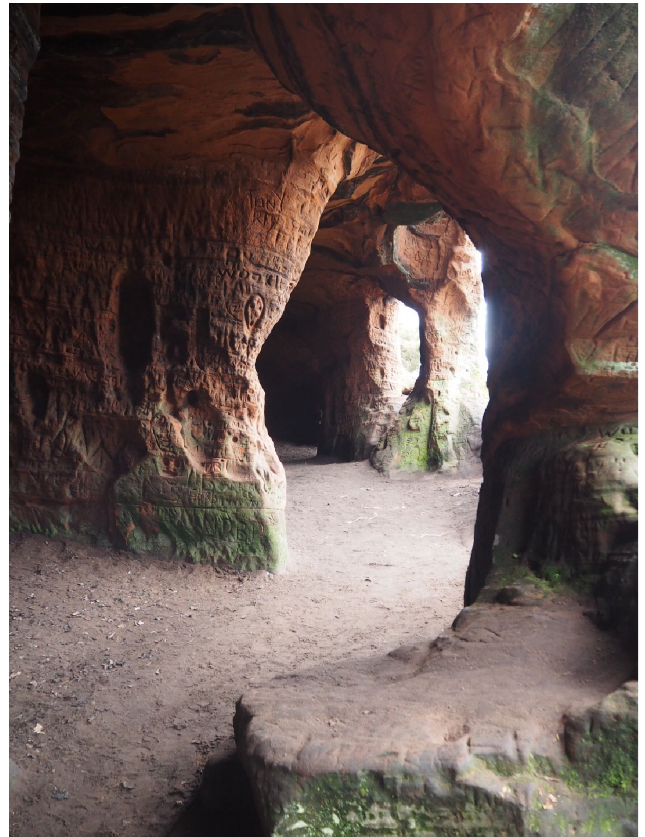
Figure 4 : Redstone Rock Hermitage. Redstone Rock Hermitage, Worcestershire, is a massive com- plex of caves comprising at least 10 main rooms and with a known later medieval history and fea- tures that suggest an early medieval origin. Photograph E.R Simons.